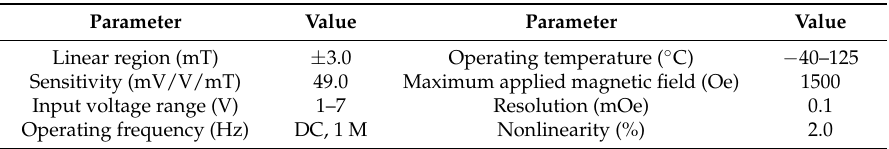
Table 3. Performance parameter of the TMR2102